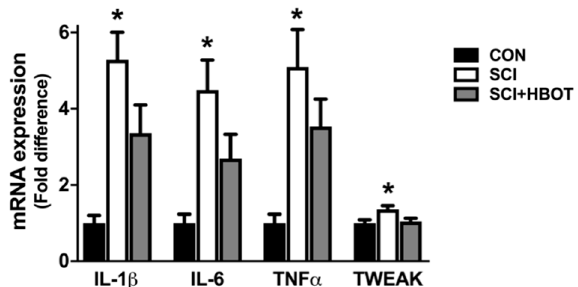
Figure 5. mRNA expression of interleukin 1 β (IL-1 β ), IL-6, tumor necrosis factor α (TNF α ) and TNF-related weak inducer of apoptosis (TWEAK). Values are mean ± SEM. * Significantly different versus CON group ( p < 0.05). CON—non-injured, room air exposure; SCI—lateral-cervical spinal cord contusion, room air exposure; and SCI + HBOT—lateral-cervical spinal cord contusion, HBO therapy.